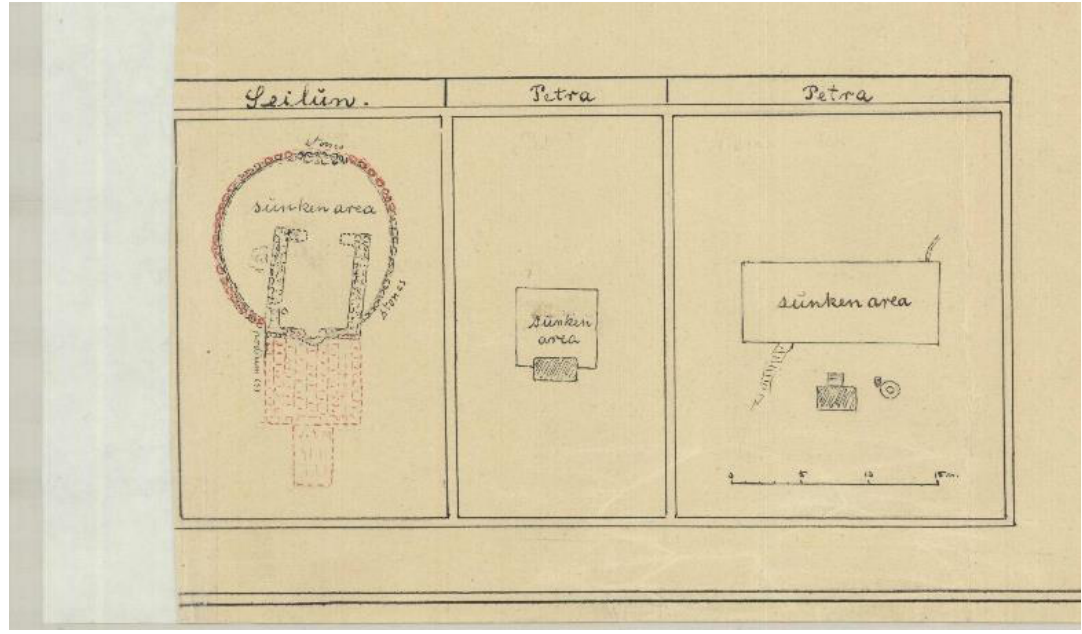
Figure 8. The open-air Weli with comparison to the altar in Petra, from the British Archive, n.d. SRF_171 (http://www.iaa-archives.org.il/zoom/zoom.aspx?id=42967&folder_id=3380&loc_id=1025) (accessed on 27 September 2020).